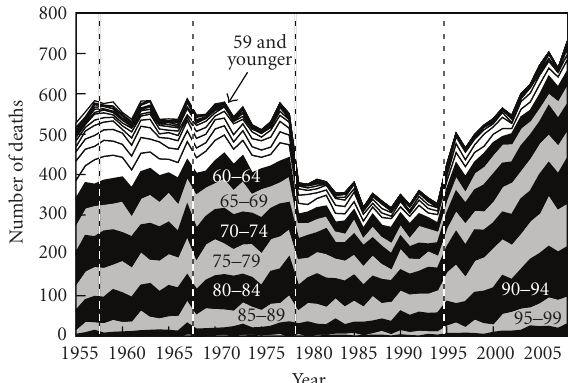
Figure 4: Annual trends in the number of deaths from NMSC by age group in Japan (1955 ∼ 2008), modified from Ohtsuka and Nagamatsu [7].